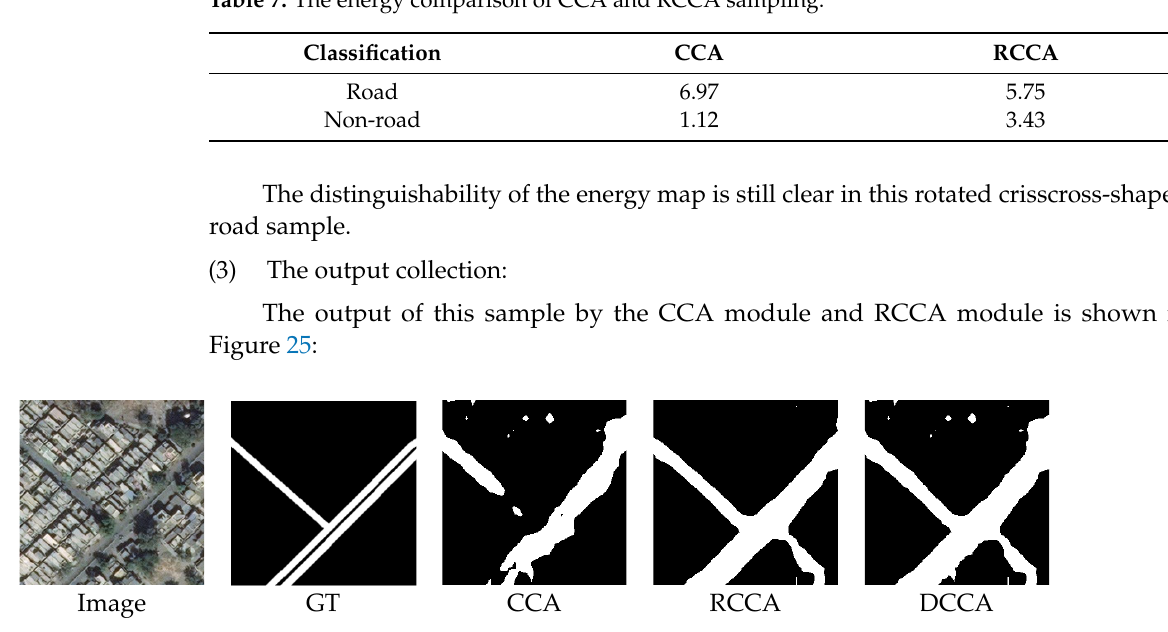
Figure 24. The energy line chart of two sampling area.